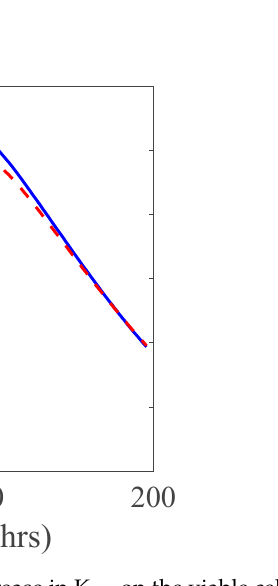
Figure 14. The effect of a 50% increase in K lag on the viable cell concentration, blue: no disturbance, red: with disturbance.